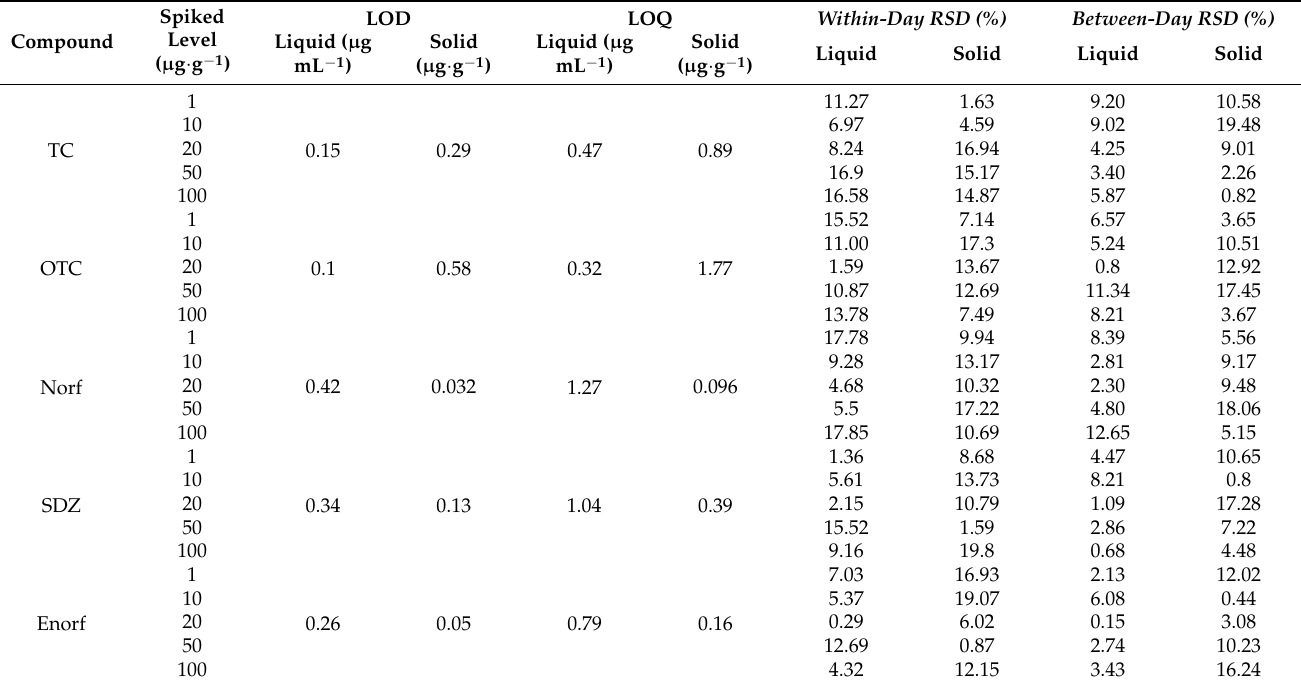
Table 5. Limits of detection (3 σ ), limits of quantification (10 σ ), standard added recoveries, and relative standard deviations (RSDs, n = 6) for the developed